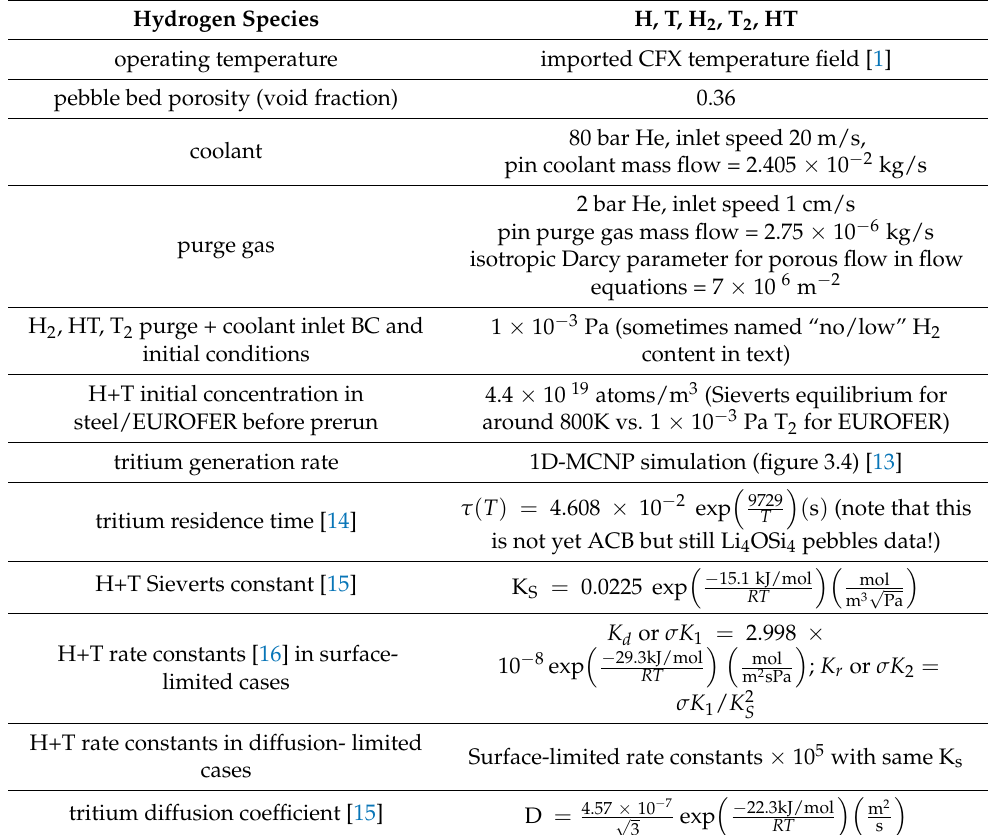
Table 1. OpenFOAM simulation